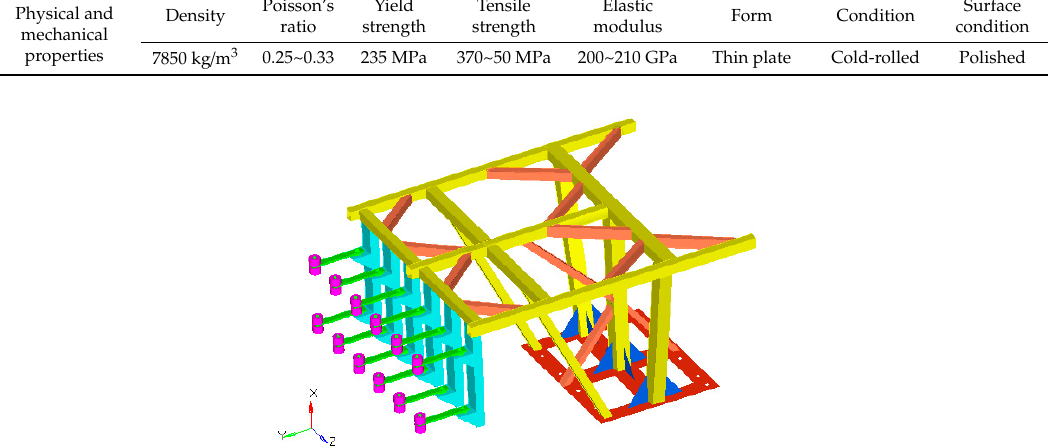
Figure 5. Finite element model.